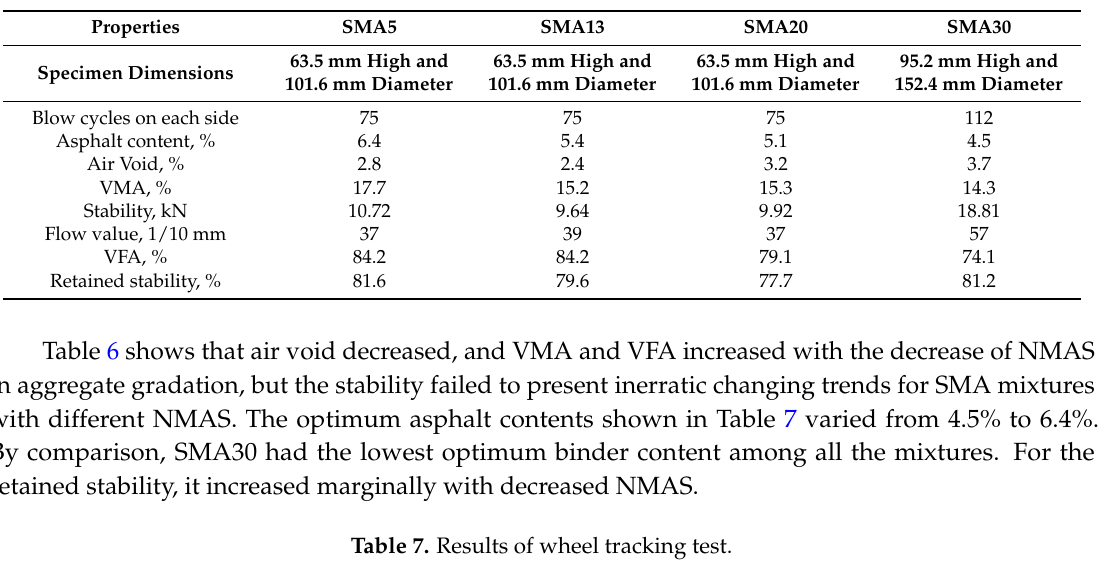
Figure 1. Flow chart of stone matrix asphalt (SMA) mixture design. Table 6. Results of SMA mixture design.